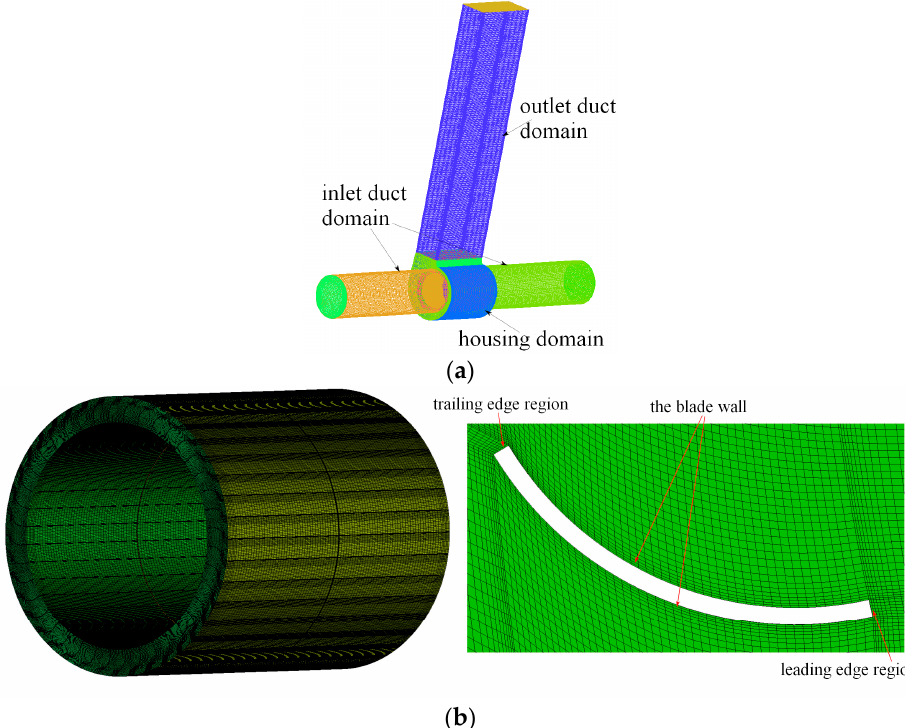
Figure 4. Computational domain of the baseline centrifugal fan: ( a ) whole computational domain; ( b ) domain for the rotating impeller and the blades.